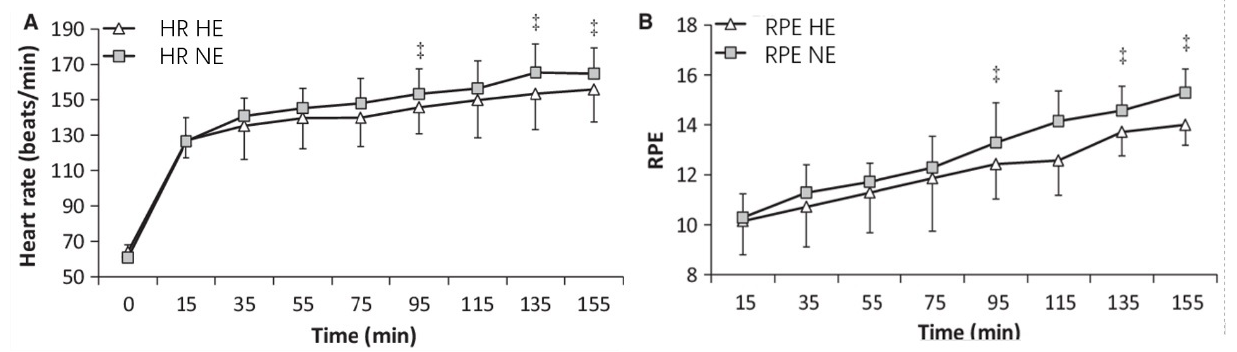
Fig. 1 The effect of exercise on HR and RPE in a thermal environment. HE, high fever group; RPE, physical performance rating.